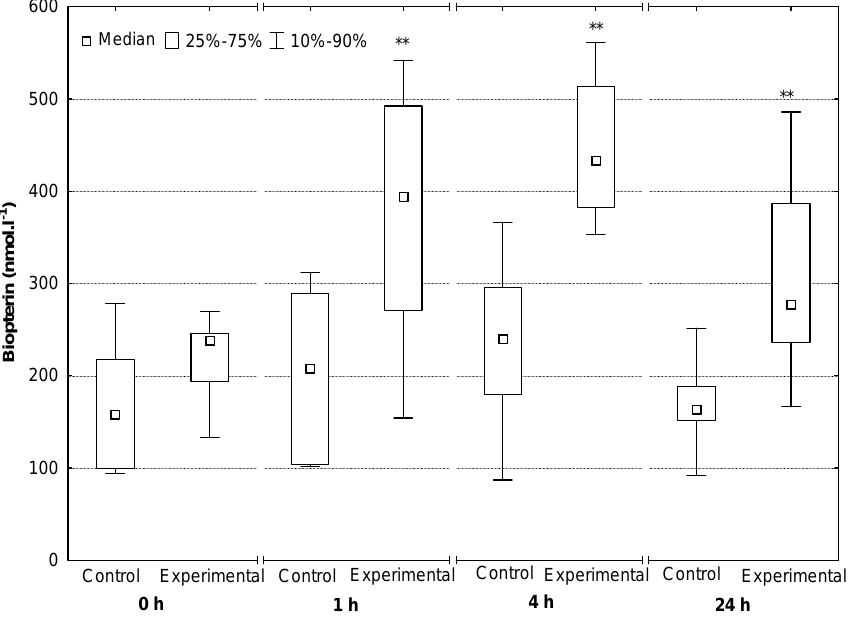
Figure 2. Serum biopterin concentrations in piglets which received no Fe 3+ -dextran (control group) and piglets administered Fe 3+ -dextran (experimental group; ** p <